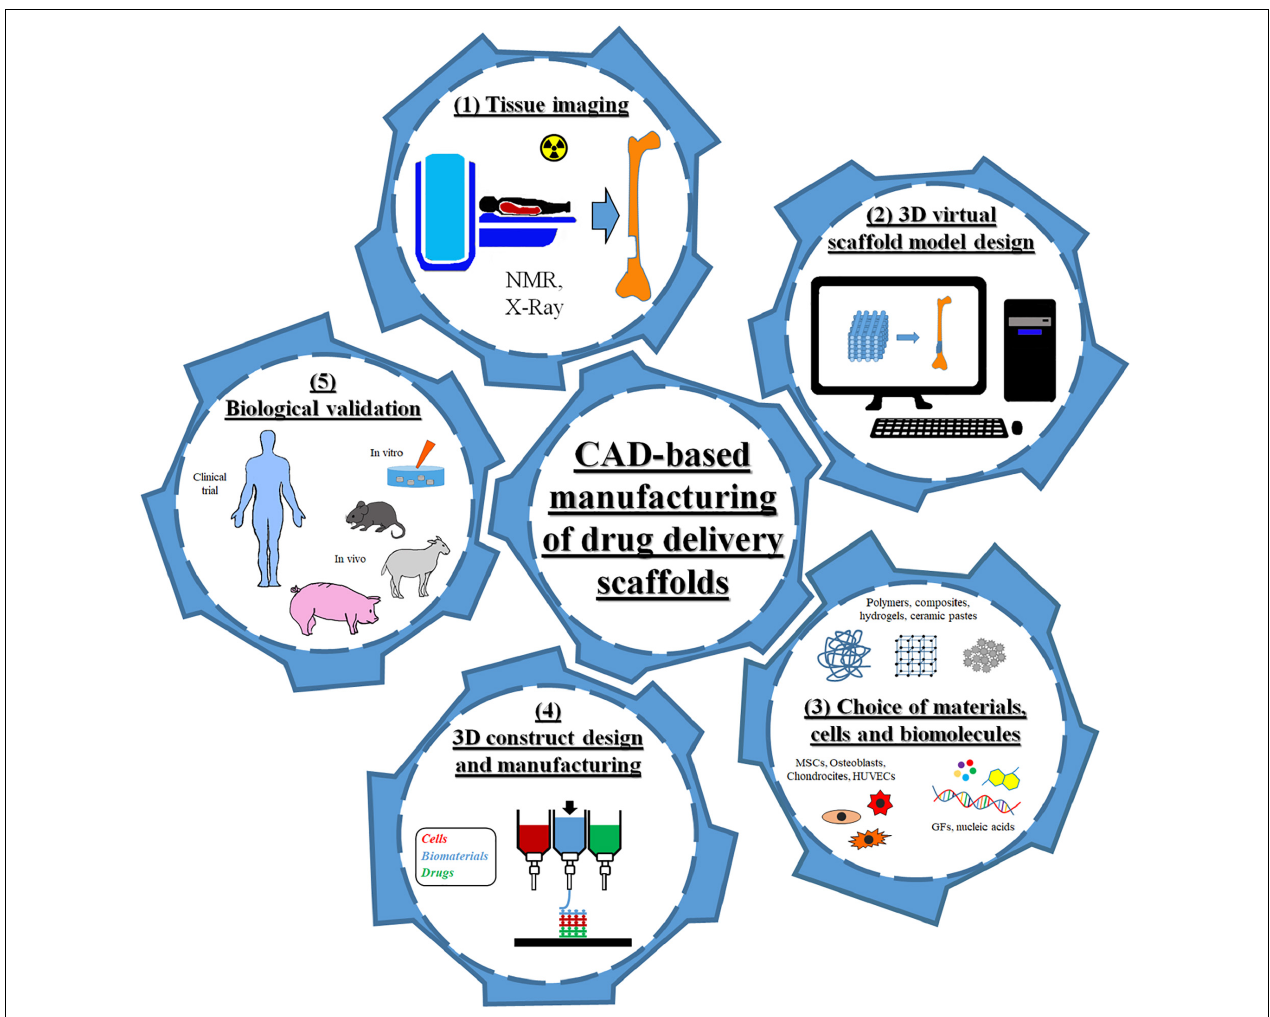
FIGURE 1 | Scheme of the different steps of computer-aided design (CAD)-based approaches for the fabrication of drug delivery scaffolds for tissue